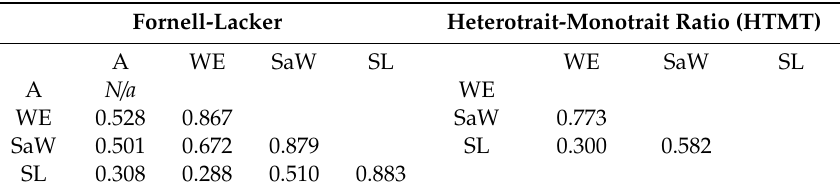
Table 4. Discriminant